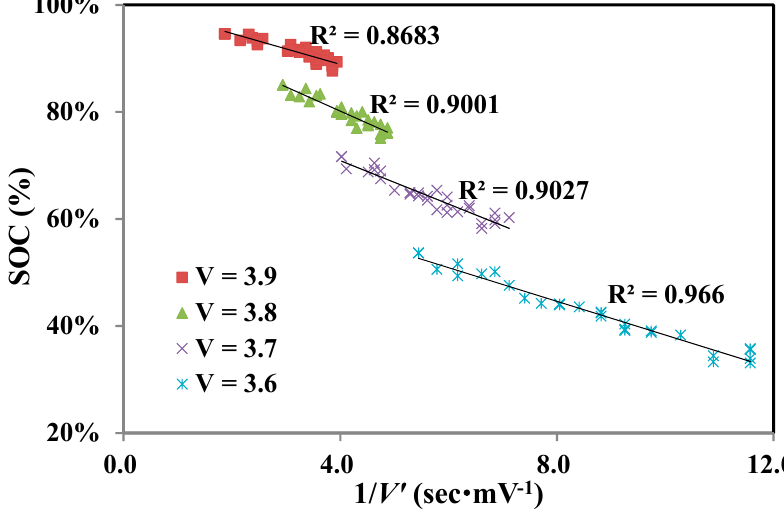
Figure 2. Correlation of SOC to 1/V ′ under an instantaneous discharge voltage from 3.6 to 3.9 volt.